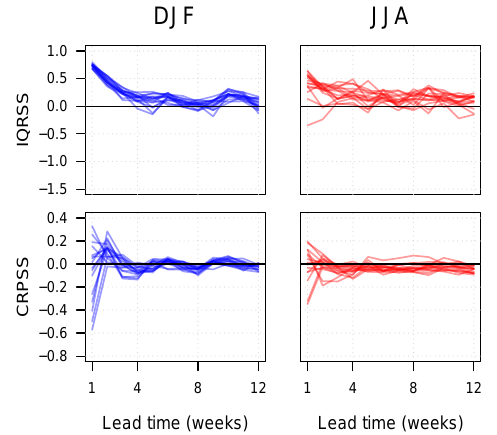
Figure 12. Skill of EDMD-m debiased streamflow forecasts as a function of the lead time for all catchments and for the winter (DJF) and summer (JJA) seasons. The skill is computed based on the IQR (top) and based on the CRPS (right) and the reference is historical streamflow. Each column corresponds to the target season of fore- cast lead times. Each plotted line represents the performance of a